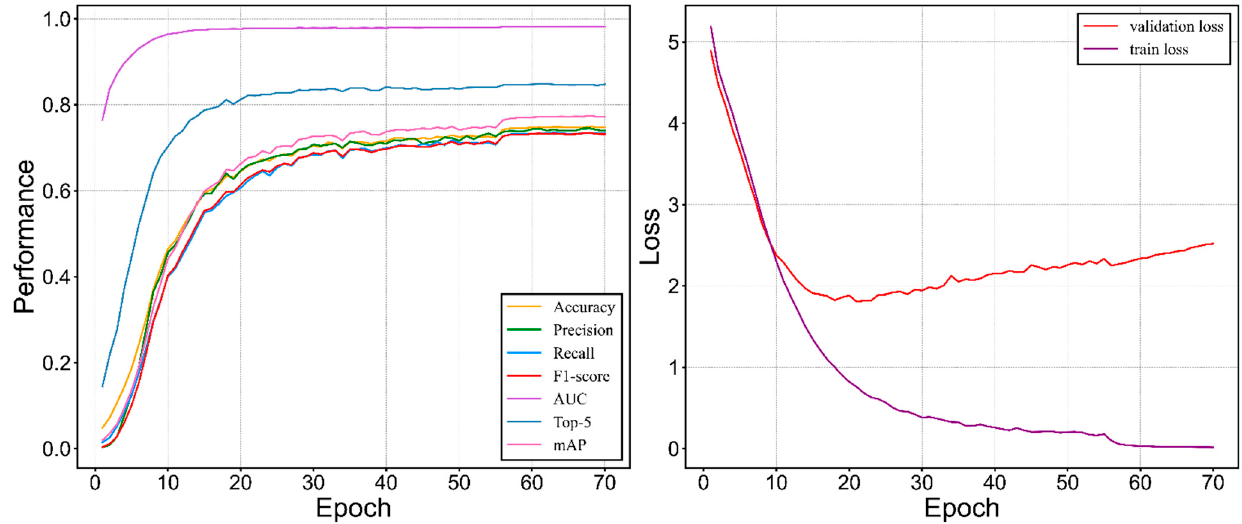
Figure 8. Performance of the proposed model. Table 3. Performance of our proposed method when different features are given as input. The best results are shown in bold